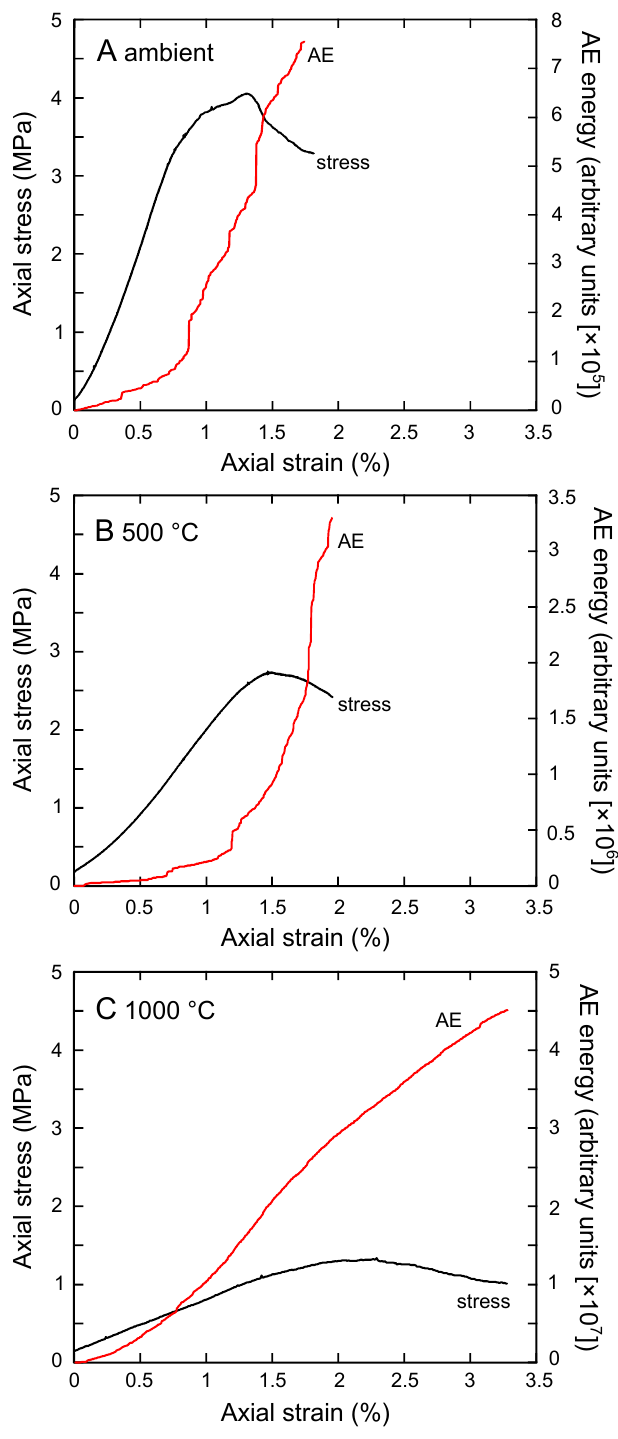
Figure 7: Uniaxial stress-strain curves for samples of Mt.